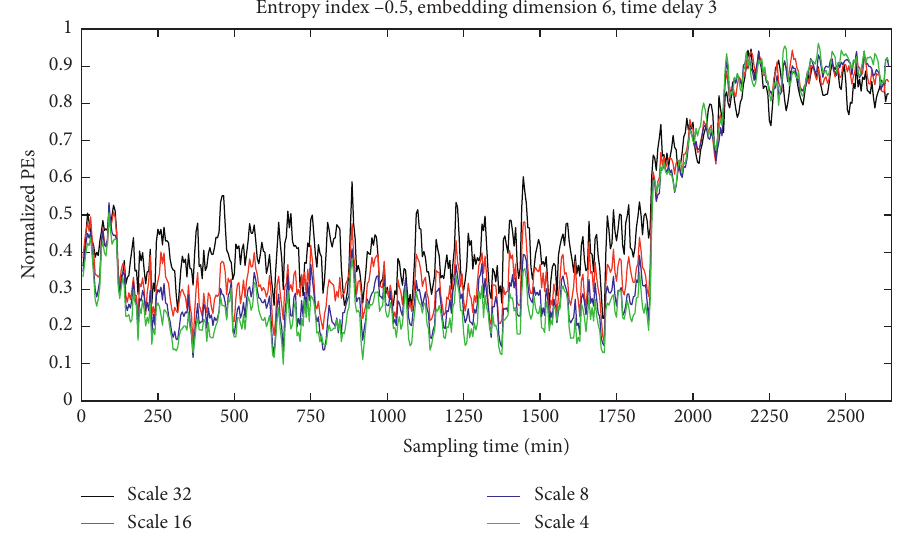
Figure 12: Results of health indicators on different scales s